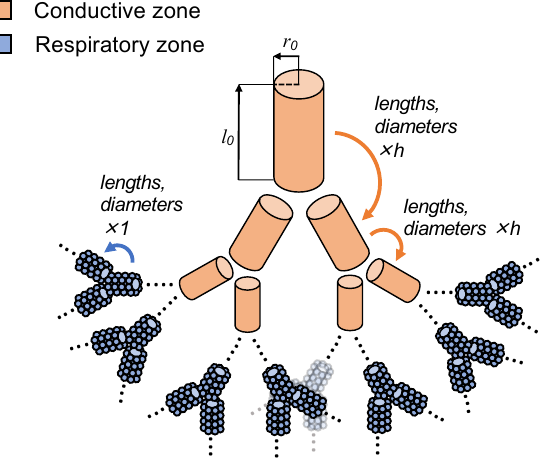
Figure 1 – Illustration of the lung model used in this work. Our model is based on the assembly of self-similar trees with symmetric bifurcations that mimic the two functional zones. The tree in beige mimics the bronchial tree, where oxygen is only transported along the branches. The tree in blue mimics the acini, where oxygen is transported along the branches and also captured in the alveoli that cover the walls of the branches. The model of oxygen transport depends only on airways lengths and diameters but not on airways spatial distribution in the lungs. Hence, branching angles and branching planes orientations are not accounted for in this